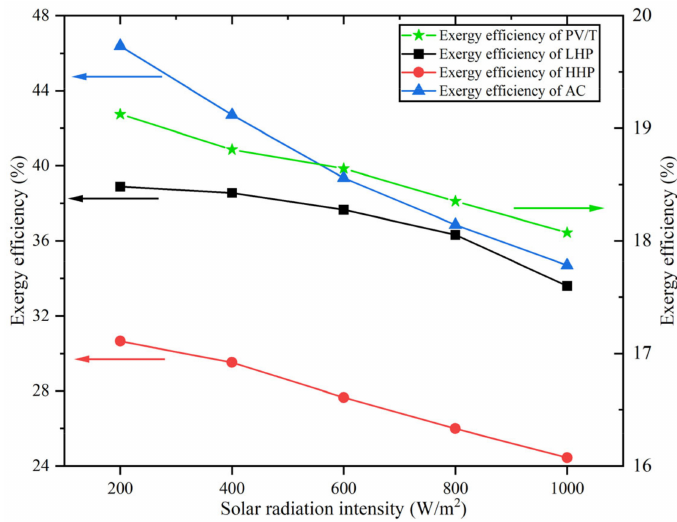
Figure 19. Exergy efficiency of equipment with different solar radiation